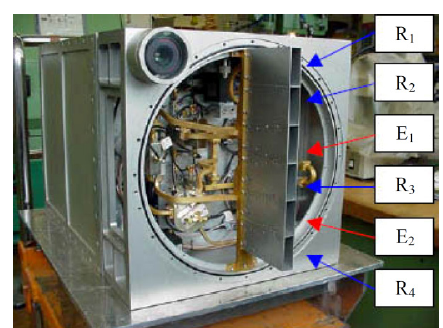
Figure 1. MEMPHIS Ka-band interferometric antenna. E1, E2: transmit horns, R1–R4: receive horns. Only one transmit horn can be used at a